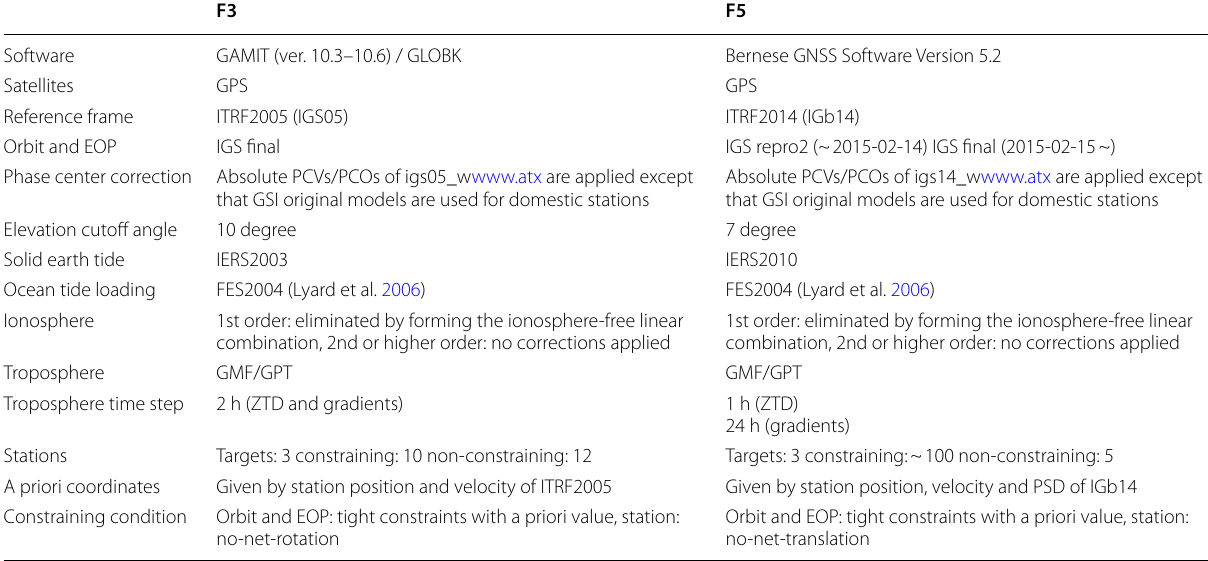
Table 2 Models and conventions used for RSA